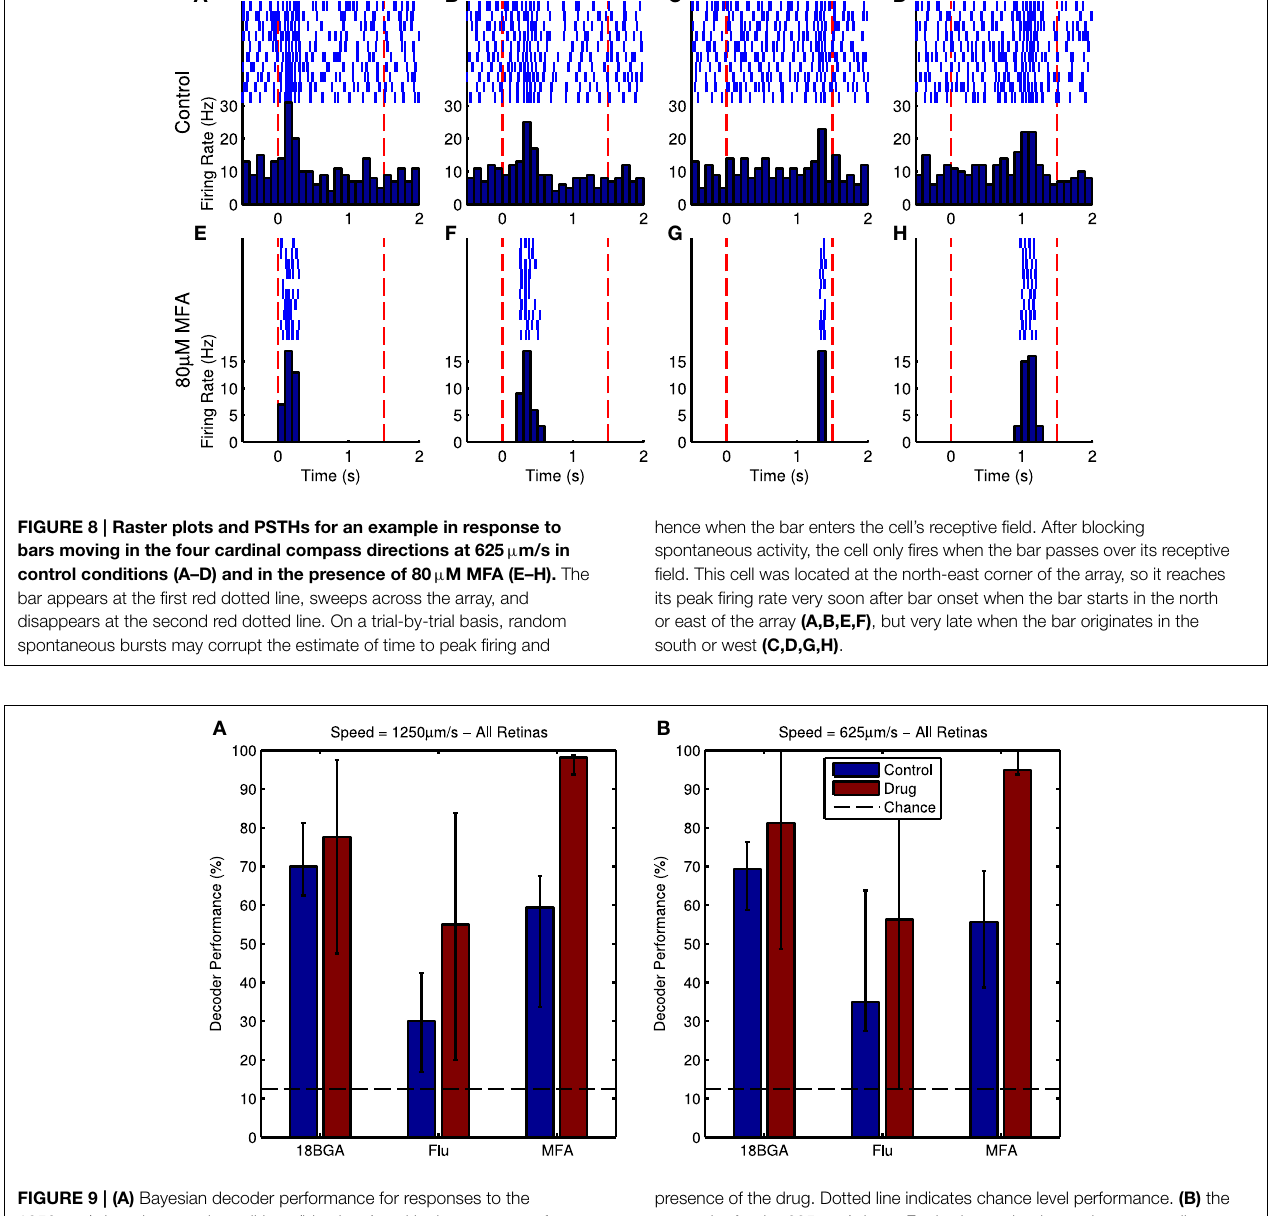
presence of the drug. Dotted line indicates chance level performance. (B) the same plot for the 625 µ m/s bars. For both panels, data points are medians over all retinas and error bars are